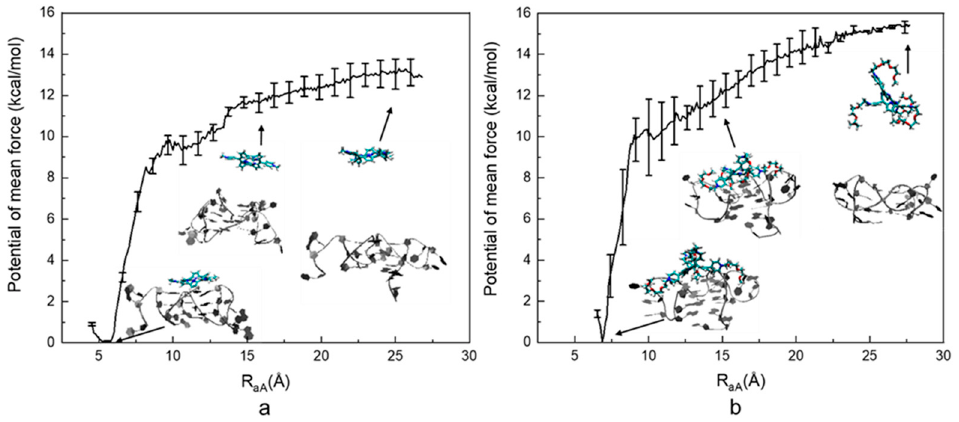
Figure 3. Computed potential of mean force of the ILPR G4-ligand systems. ( a ) PMF profile of the ILPR G4-TMPyP4 system. ( b ) PMF profile of the ILPR G4-TEGPy system. Intermediate confor-